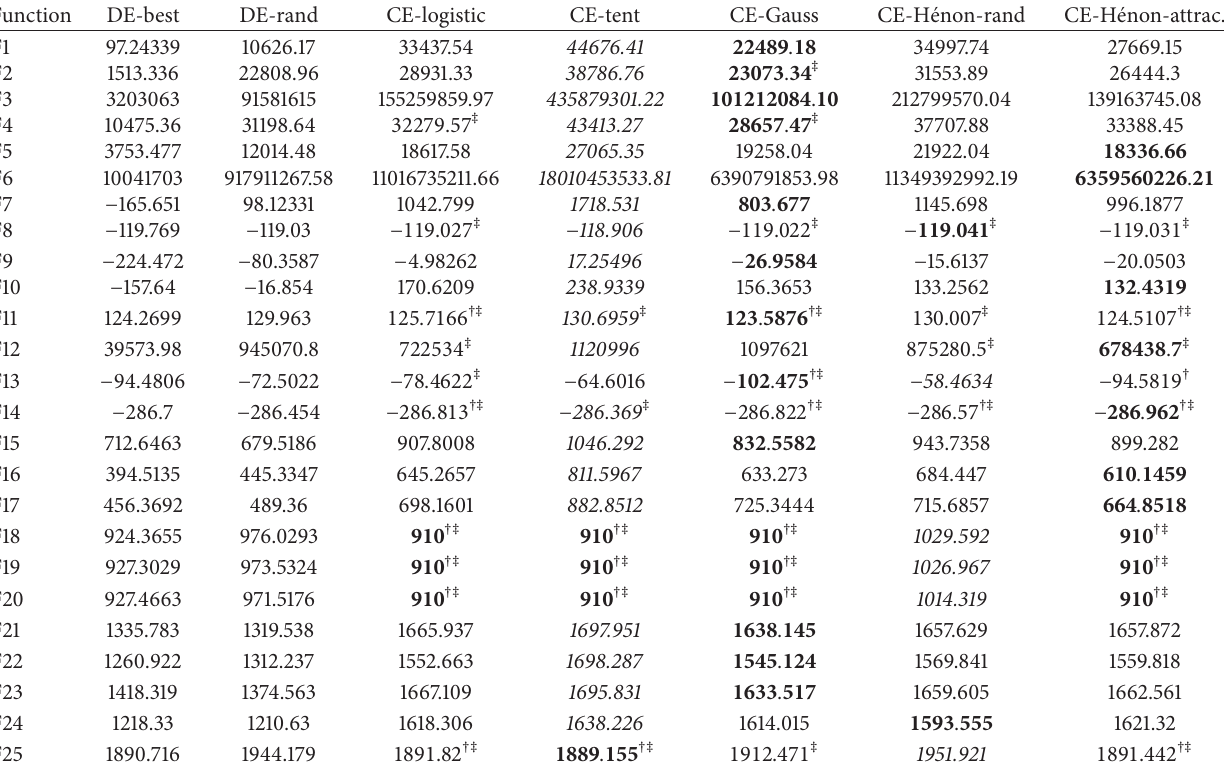
Table 4: Mean fitness values of F1–F25 with 30D. The explanations of special marks are as the same as in Table 3.